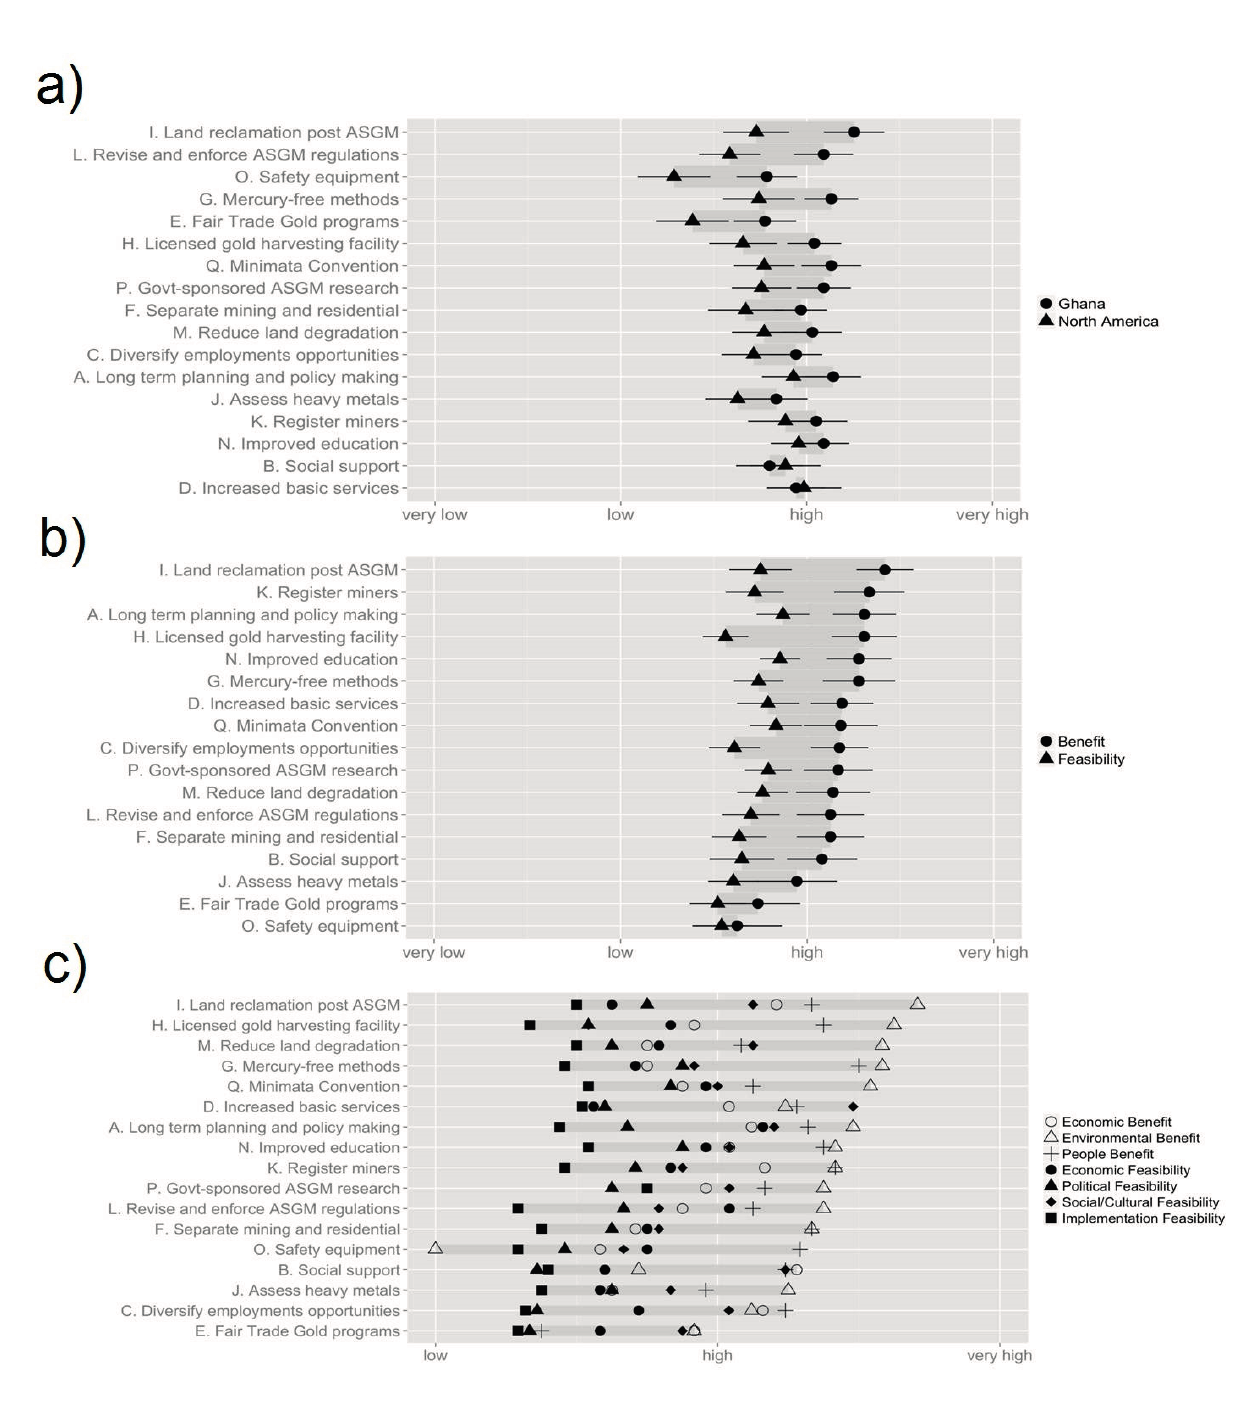
Figure 2. Delphi poll scores from the first Delphi poll, conducted among academics (n = 27) in March 2014. ( a ) Overall score for each option, grouped by region, sorted by difference; ( b ) Overall score for each option, grouped by benefit and feasibility, sorted by decreasing benefit; ( c ) Overall score for each option, grouped by topic, sorted by maximum